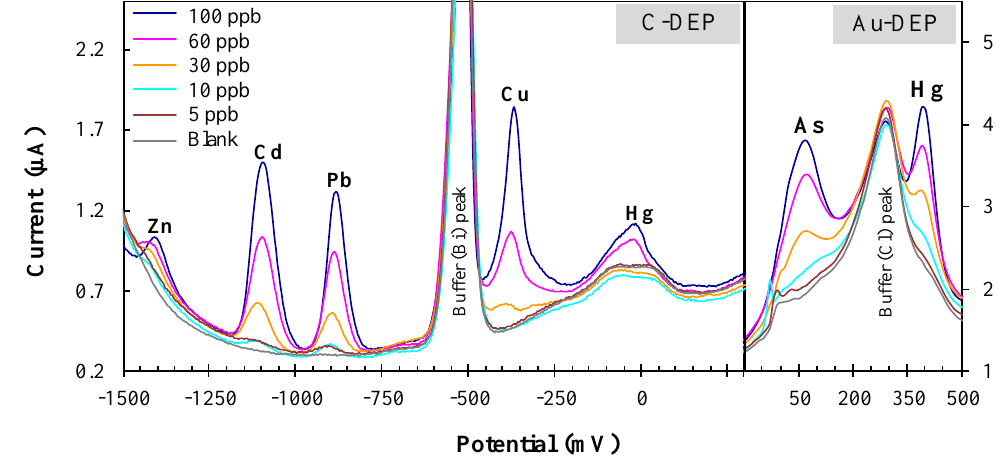
Figure 3. Simultaneous electrochemical measurement of six heavy metals in a standard solution using the “DEP-On-Go” system. DP voltammograms are shown for the detection of zinc, cadmium, lead, and copper using a carbon DEP chip (C-DEP), and arsenic and mercury using a gold DEP chip (Au-DEP) in standard solutions. The data are the averages of four to six independent experiments.